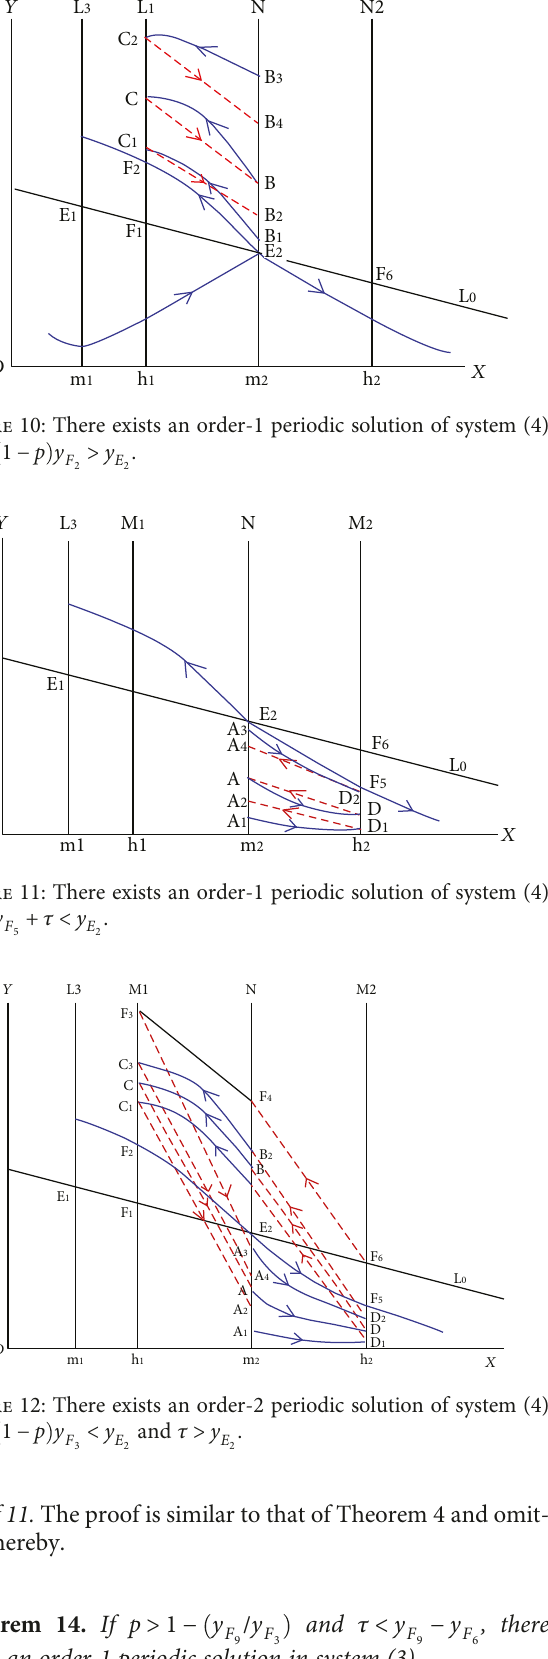
2 of system (3) with